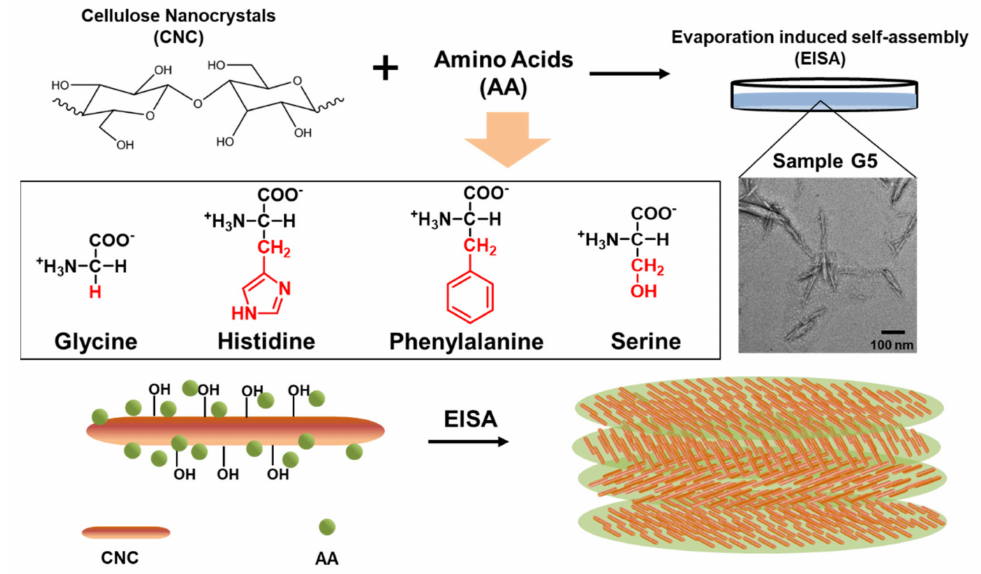
Figure 1. The scheme of the CNCs–AA composite films preparation: the molecular structures of four types of AAs; TEM image of sample G5 suspensions; and the proposed model for CNCs incorporated with AA particles during